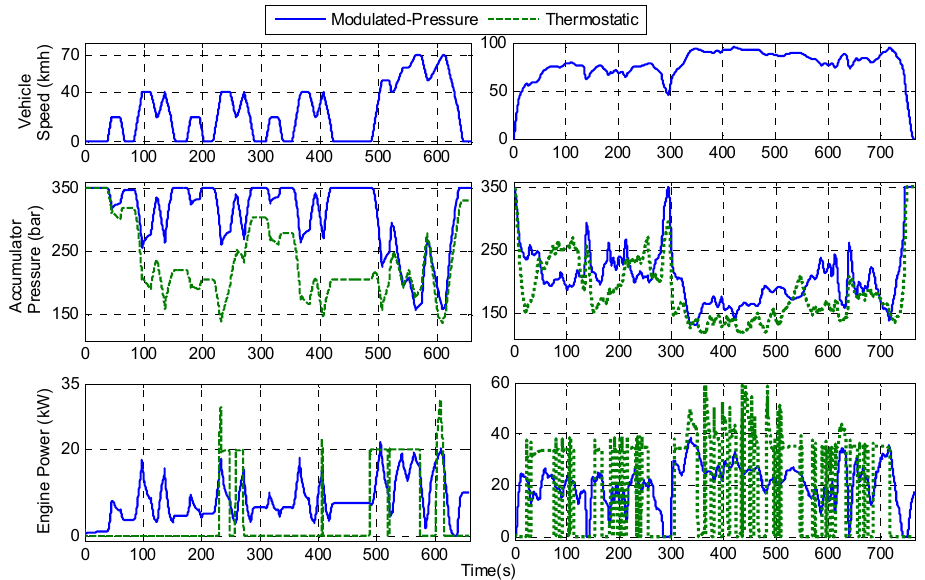
Figure 15. Modulated-Pressure and Thermostatic Control Strategies Comparison.